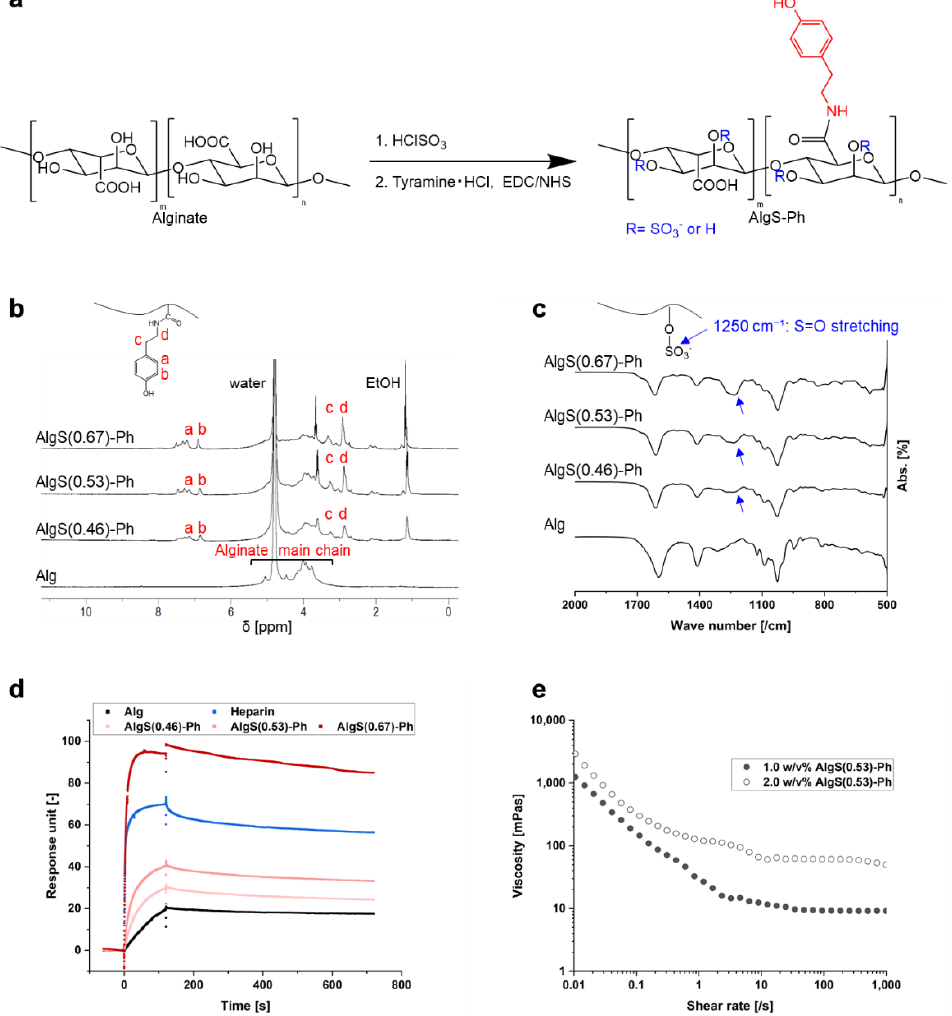
Figure 2. Characterization of AlgS-Ph. ( a ) Reaction scheme for preparing AlgS-Ph. ( b ) 1 H NMR spectra of AlgS-Ph (D 2 O, 400 MHz). ( c ) FTIR spectra of AlgS-Ph. ( d ) SPR analysis of alginate (Alg), AlgS-Ph at various degrees of sulfation and heparin. FGF-2 is immobilized on the sensor surface. ( e ) Shear-rate–viscosity profiles of solutions containing different concentrations of AlgS(0.53)-Ph (1.0 w / v % and 2.0 w / v %) at 25 °C.